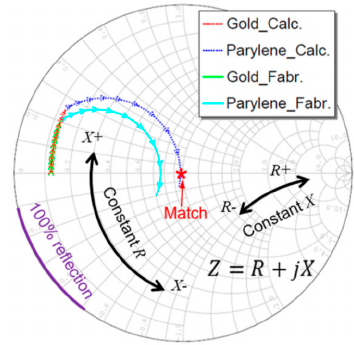
Figure 15. Smith chart showing the acoustic impedance loci of transducer normalized to 12.13 MRayl and obtained using the transmission line model (Calc.) and KLM-based spring-mass model (Fabr.). Reprinted from [154], with the permission of AIP Publishing.